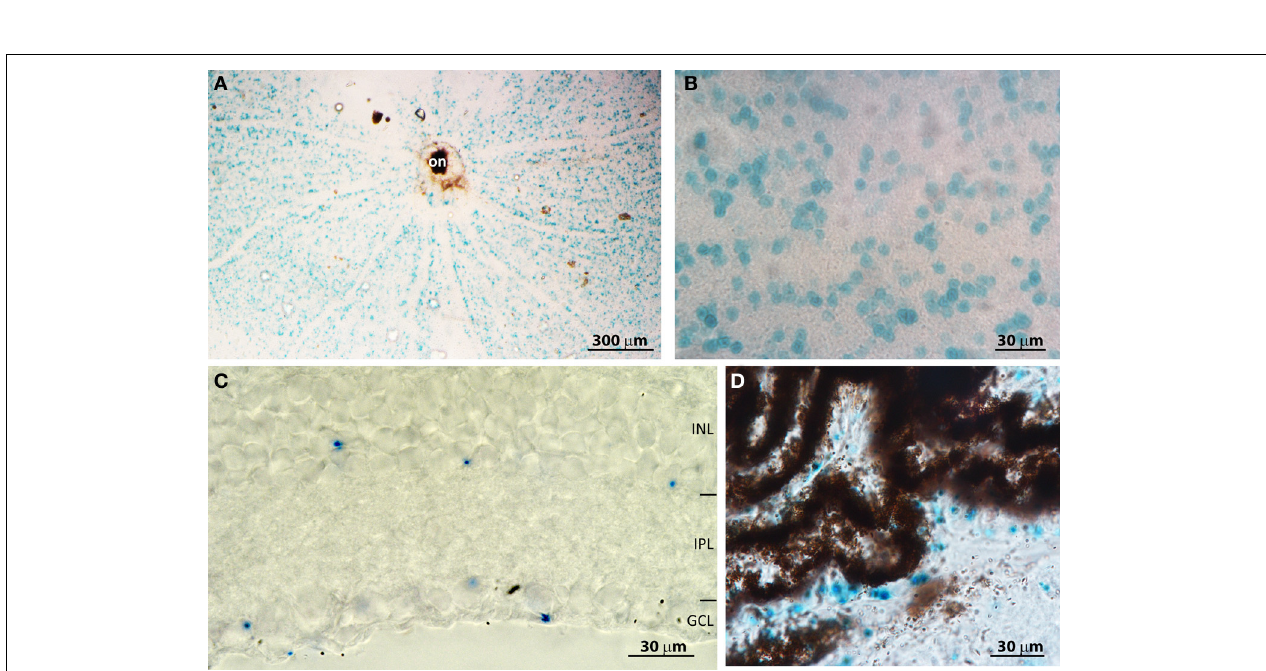
and decay to 66% of its amplitude was significantly longer in KO at all intensities. (D) Average response of WT and KO retinas to green light of intensity 3 . 2 × 10 4 photons μ m − 2 ( n = 16 for WT and 19 for KO). (E) Amplitudes of the a- and b-waves from WT ( n = 7–11) and KO ( n = 2–11). Mice at increasing intensities of green light. (F) The times taken by the b-wave to rise and fall to 66% of its amplitude: both parameters are significantly longer in KO.